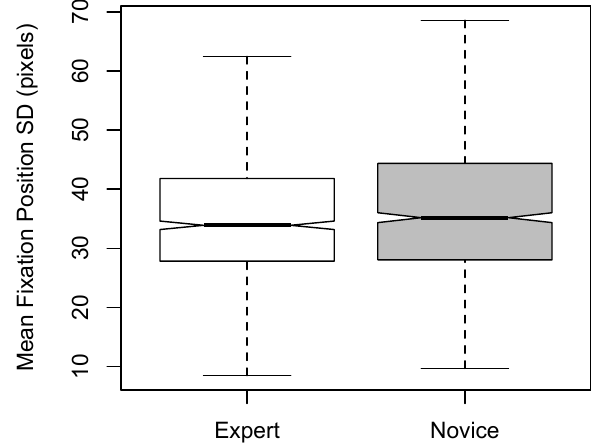
Figure 5. Notched boxplots of mean fixation position SD per time window for Expertise (experts and